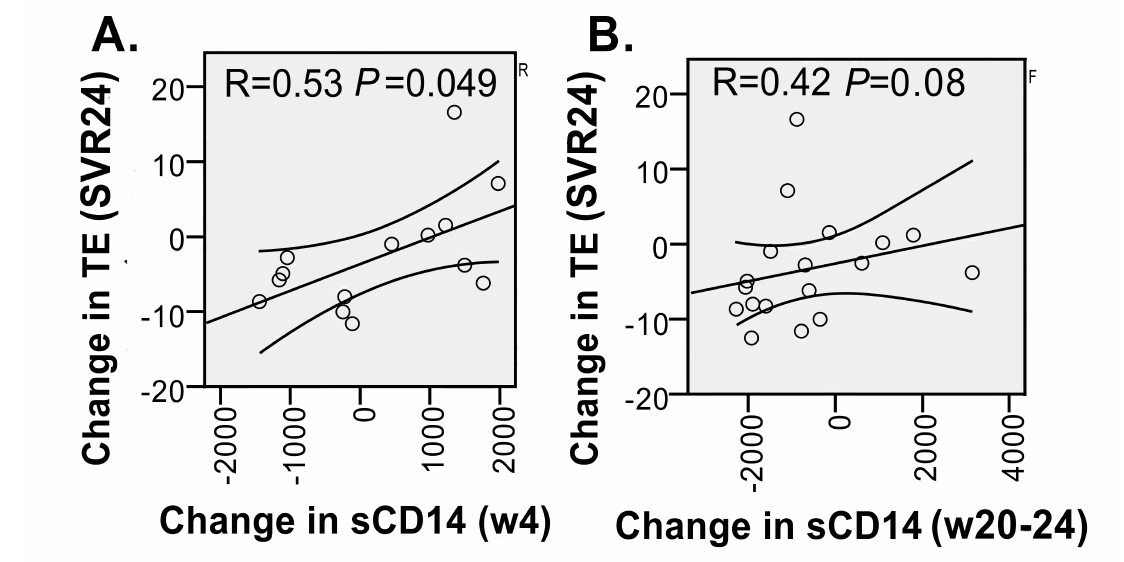
Figure 3. Correlation between change in sCD14 and change in TE score over the course of IFN-free therapy. A) Change in sCD14 (week 4 [w4]-baseline) vs Change in TE score (SVR24 or 24 weeks post therapy-baseline). B) Change in sCD14 (week 20-24 [w20-24]-baseline) vs Change in TE score (SVR24 or 24 weeks post therapy-baseline). Spearman rank correlation coefficient and P value are shown in each panel and 95% confidence